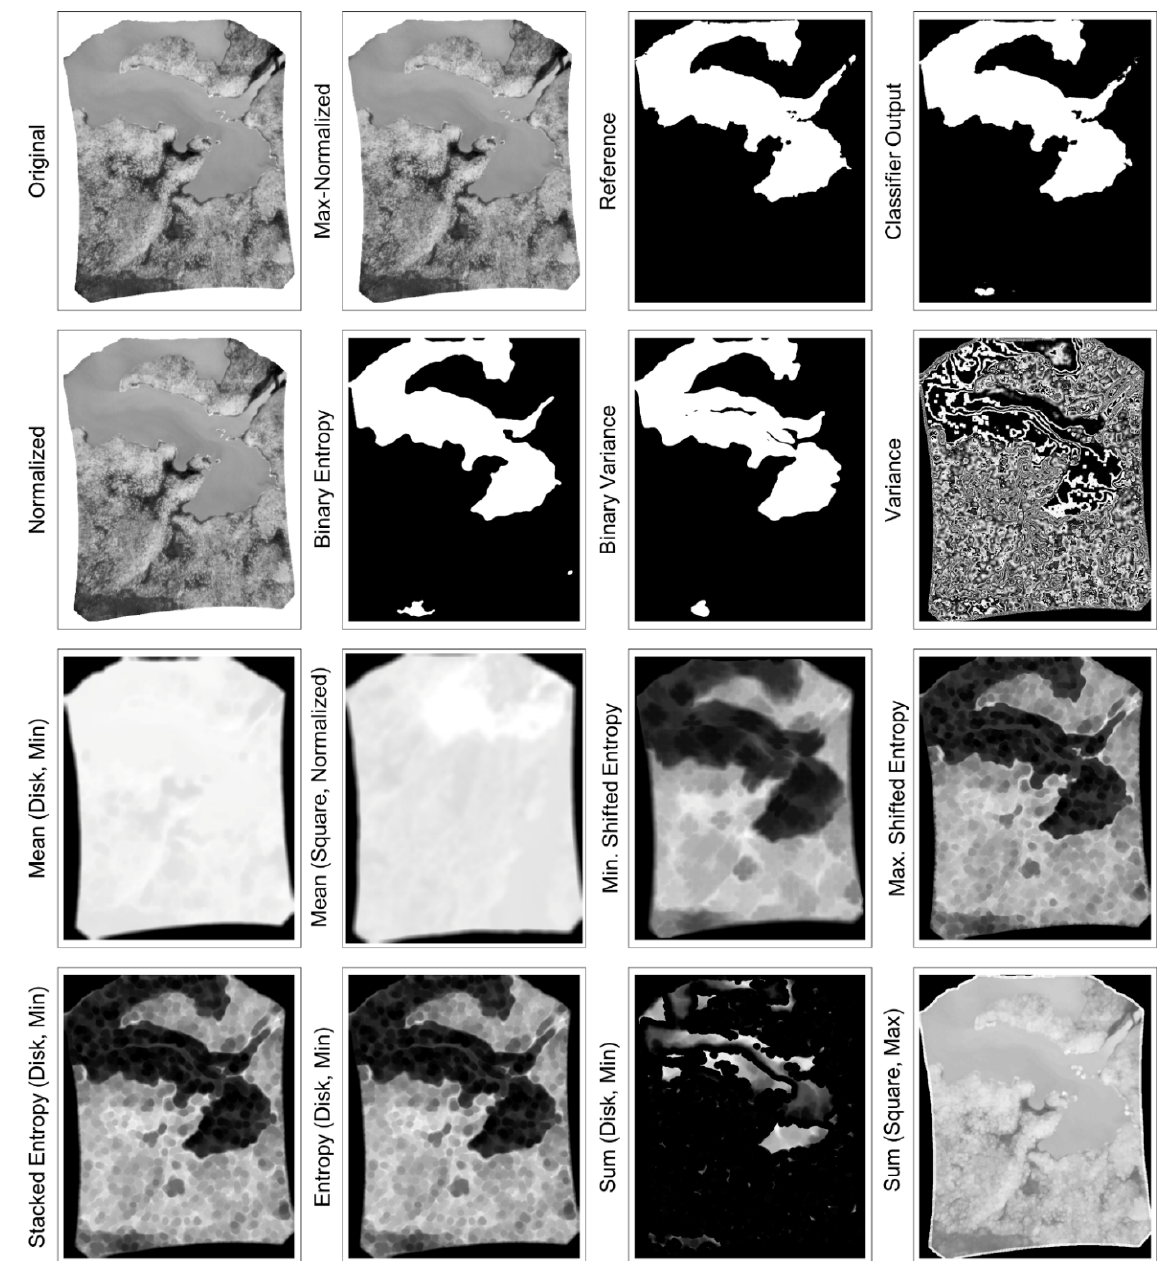
Figure 9. Sample of significant features for IR image without fire pixels.